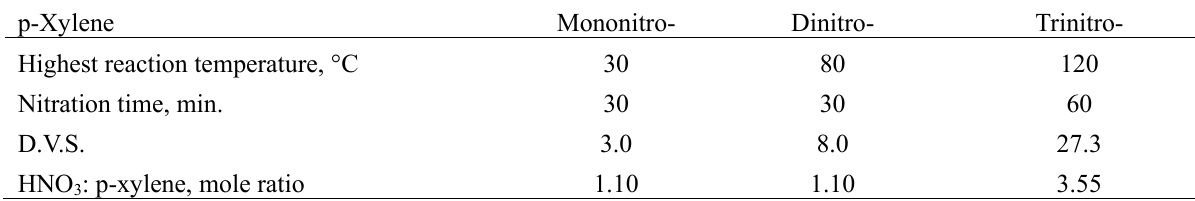
Table 1 The optimal reaction conditions for synthesis nitro-p-xylene p-Xylene Mononitro- Dinitro- Trinitro- Highest reaction temperature, °C 30 Nitration time,